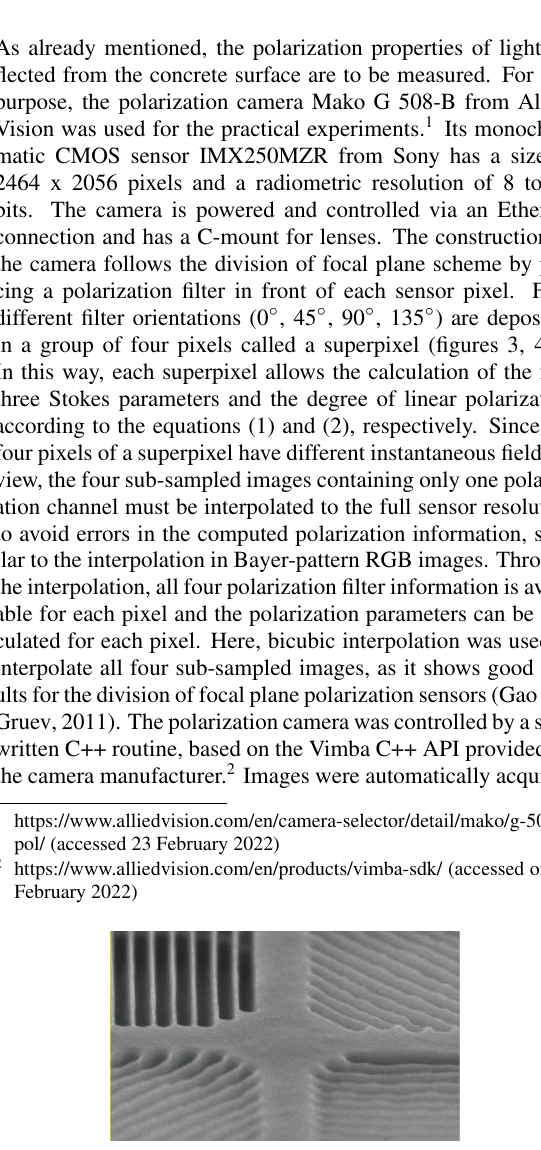
Figure 3. Photograph of the polarization camera’s wire grid,